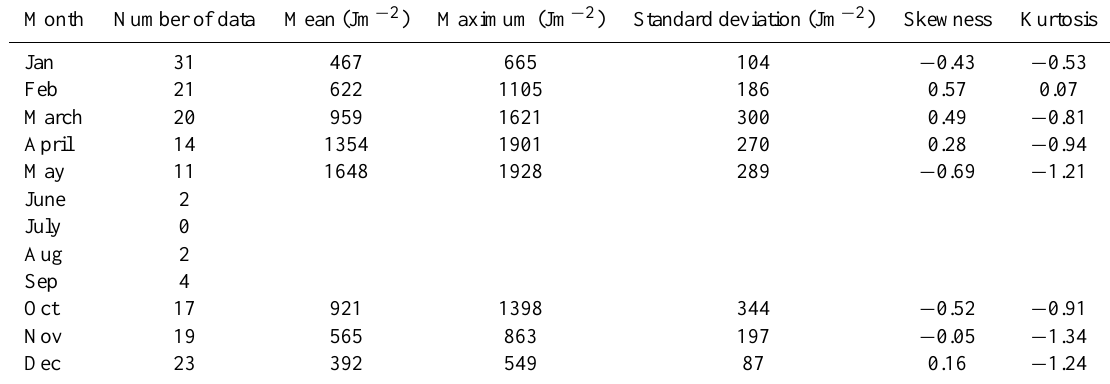
Table 3. Statistical parameters of daily ultraviolet erythemal irradiation for each calendar month for cloudy